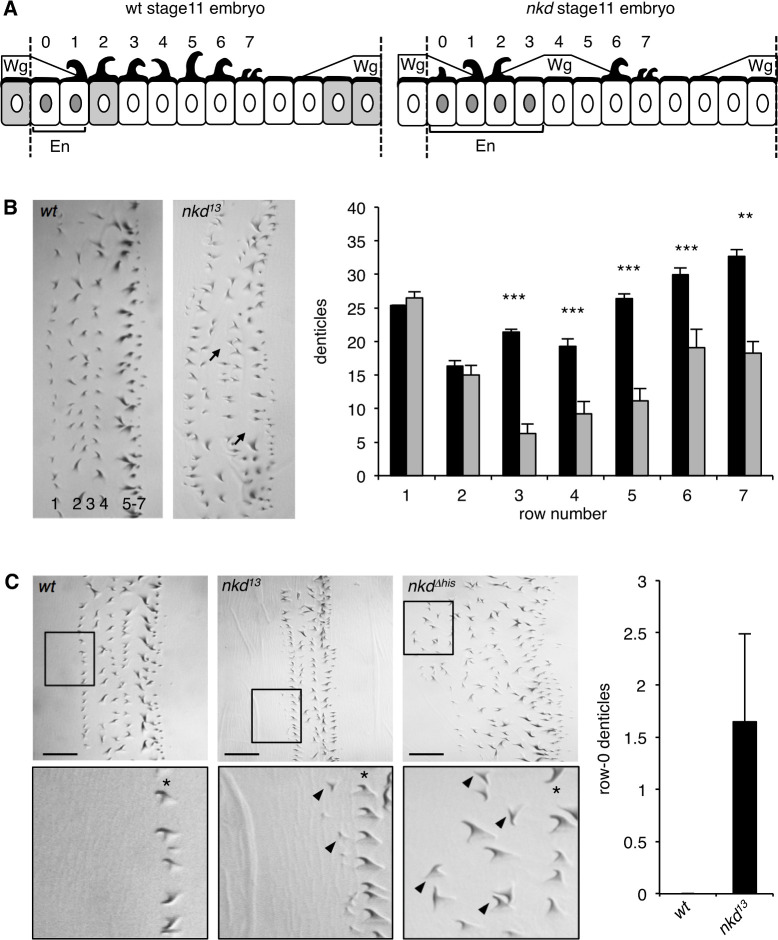
Quantification of context-dependent Wg signaling defects in embryos bearing CRISPR alleles.(A) Cartoons of row-specific ventral denticles relative to expression domains of Wg, En, and Nkd in stage 11 wt (left) and nkd13 null-mutant (right) embryos; numbers indicate denticle rows; see also text. (B) Left, examples of abdominal denticle belts in wt and nkd13 homozygous embryos, with arrows pointing to missing denticles; right, quantitation of numbers of denticles per row in wt (black bars) or nkd13 null-mutant (white bars) embryos (n = 10 near-normal denticle belts); Student’s unpaired t-test; **p < 0.01, ***p < 0.001. (C) Left, nkd13 and nkdΔhis homozygous but not wt embryos exhibit excess row-0 denticles (arrowheads; asterisks mark row-1); right, quantitation of excess row-0 denticles in nkd13 mutants (n = 20 near-normal denticle belts).